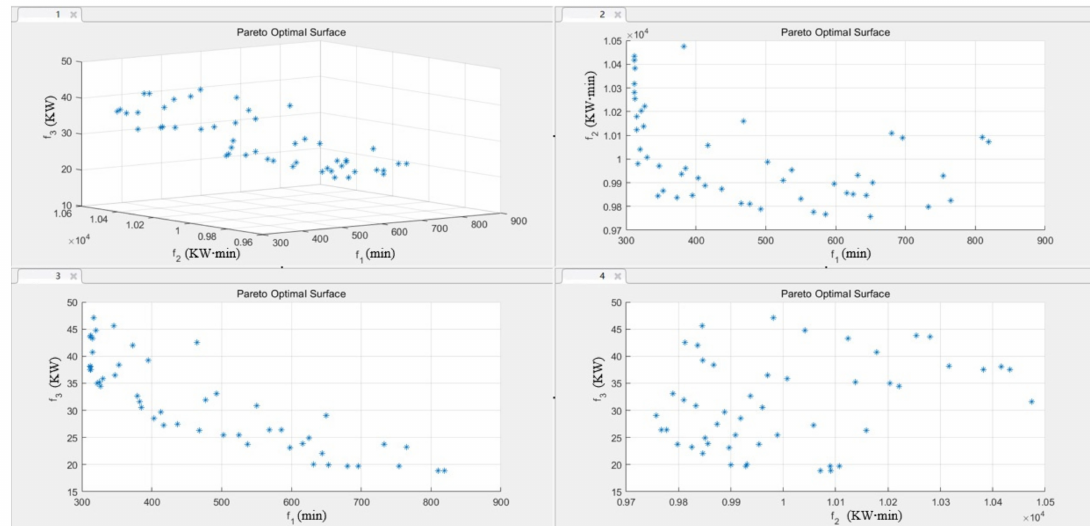
Figure 12. Distributions of the Pareto front from multiple perspectives for case